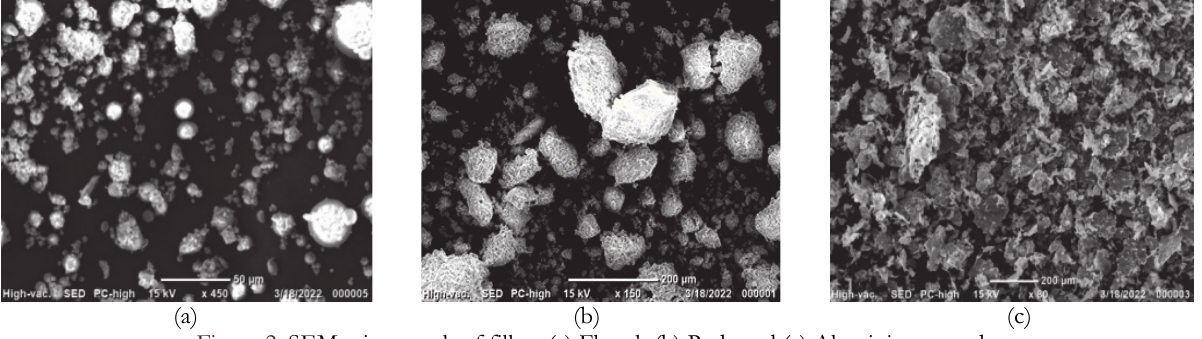
Figure 2: SEM micrograph of fillers (a) Fly ash (b) Red mud (c) Aluminium